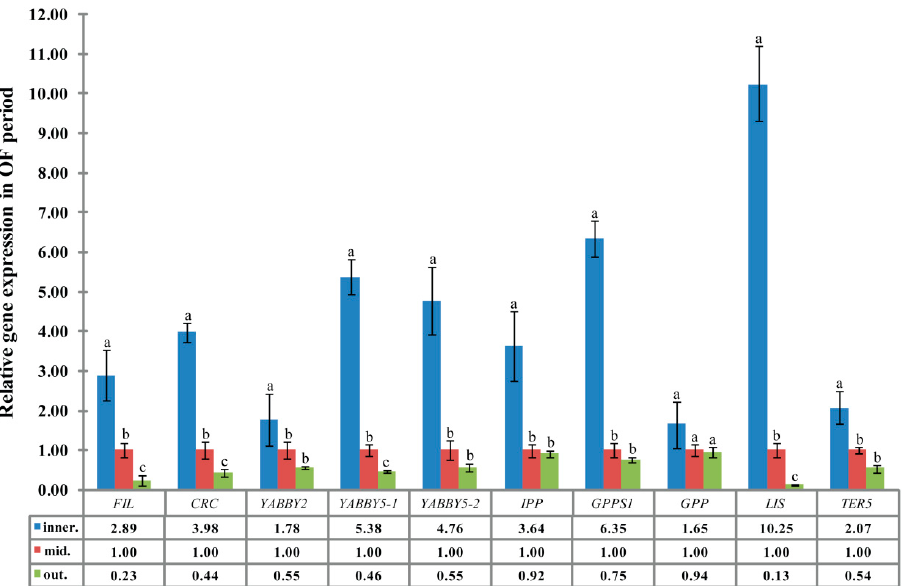
Figure 7. Quantitative real-time PCR analysis of different genes in three different rounds of petals in OF stages. Inner., mid., and out. represent innermost, middle, and outer petals, respectively. Tublin homologous gene of C . praecox was used as aninternal control. (Notes: t -test used for significant difference analysis; data is the means of relative expression; a, b, c show p < 0.05 significant level).